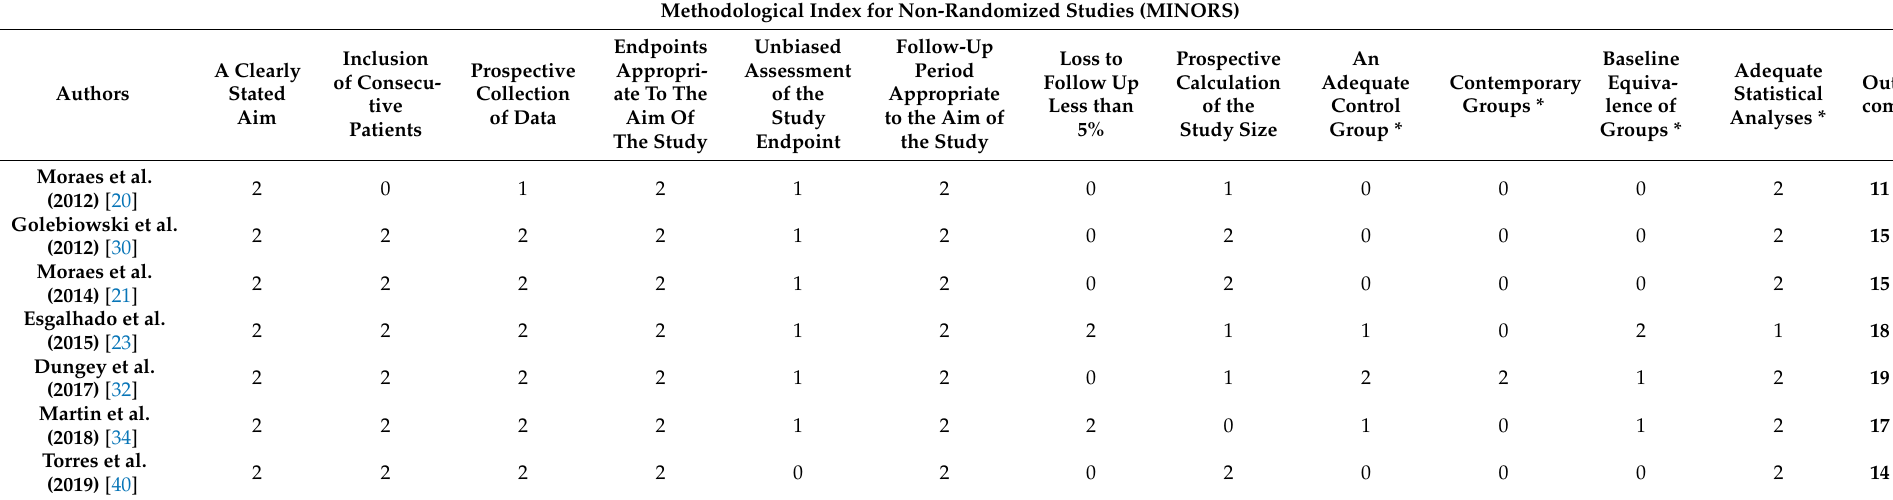
The items are scored 0 (not reported), 1 (reported but inadequate) or 2 (reported and adequate). The global ideal score being 16 for non-comparative studies and 24 for comparative studies. * Additional criteria in case of comparative